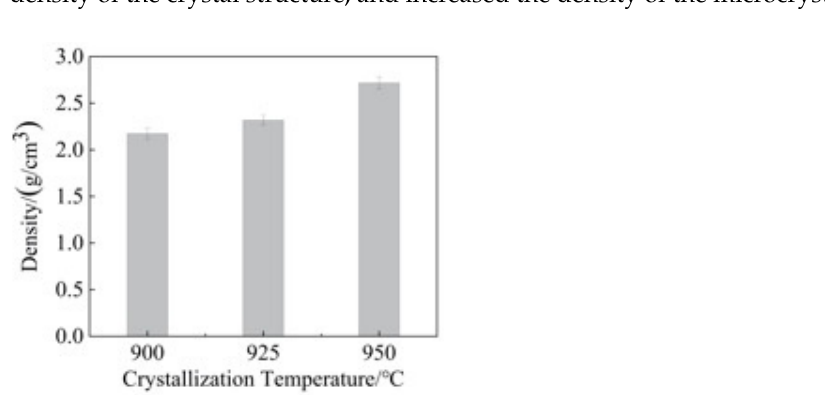
Figure 4. SEM images of microcrystalline glass samples at different crystallization temperatures: ( a ) 900 °C, ( b ) 925 °C, and ( c ) 950 °C.